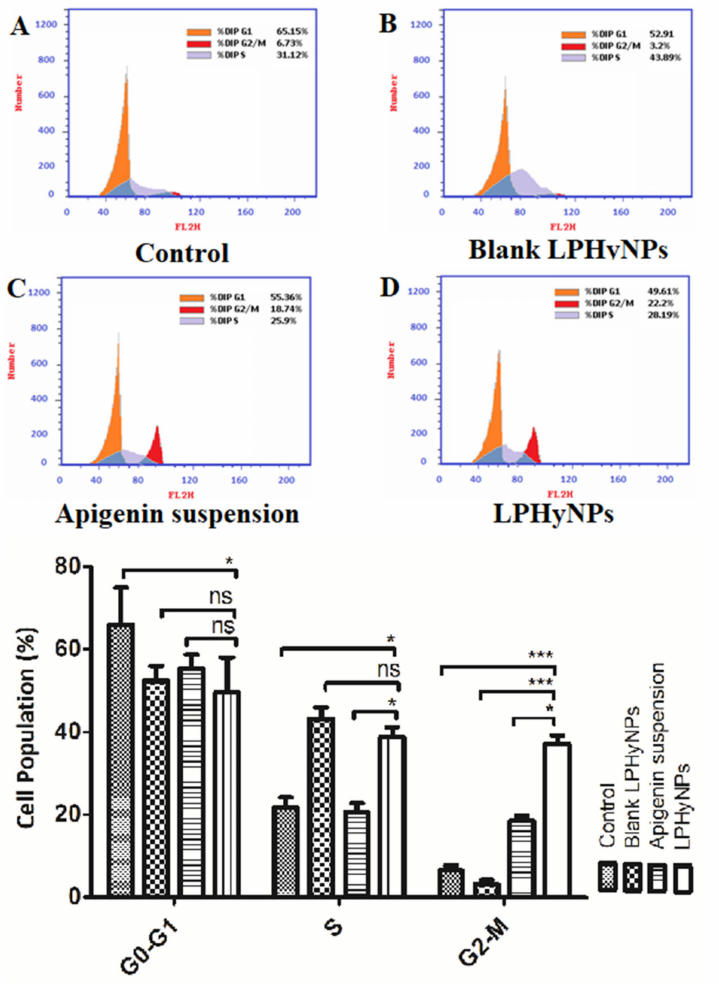
Figure 8. Figure 8 showing the outcome of cell cycle analysis using flow cytometry where effect of different groups such as ( A ) control, ( B ) Blank LPHyNPs, ( C ) apigenin and ( D ) LPHyNPs were evaluated. Values are presented as mean ± SD where p < 0.05 and p < 0.001 was represented by * and ***. ‘ns’ demonstrated non-significance differences between